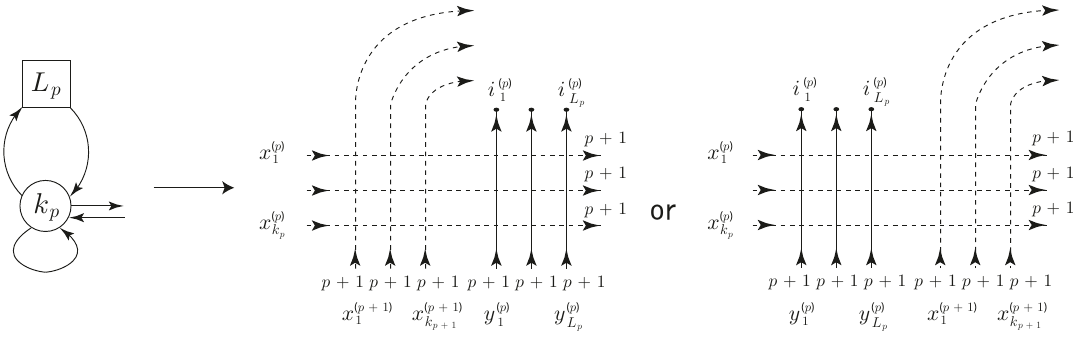
Figure 13 . Two possible lattice configurations that can be associated with the p -th quiver node, where p = 2 , . . . , M − 1.